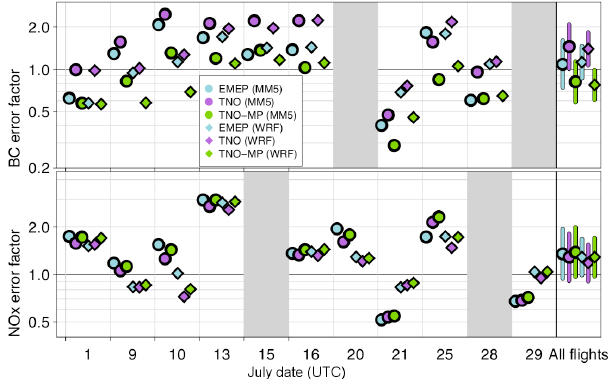
tions in one transect (see Fig. S8 in the Supplement). Only